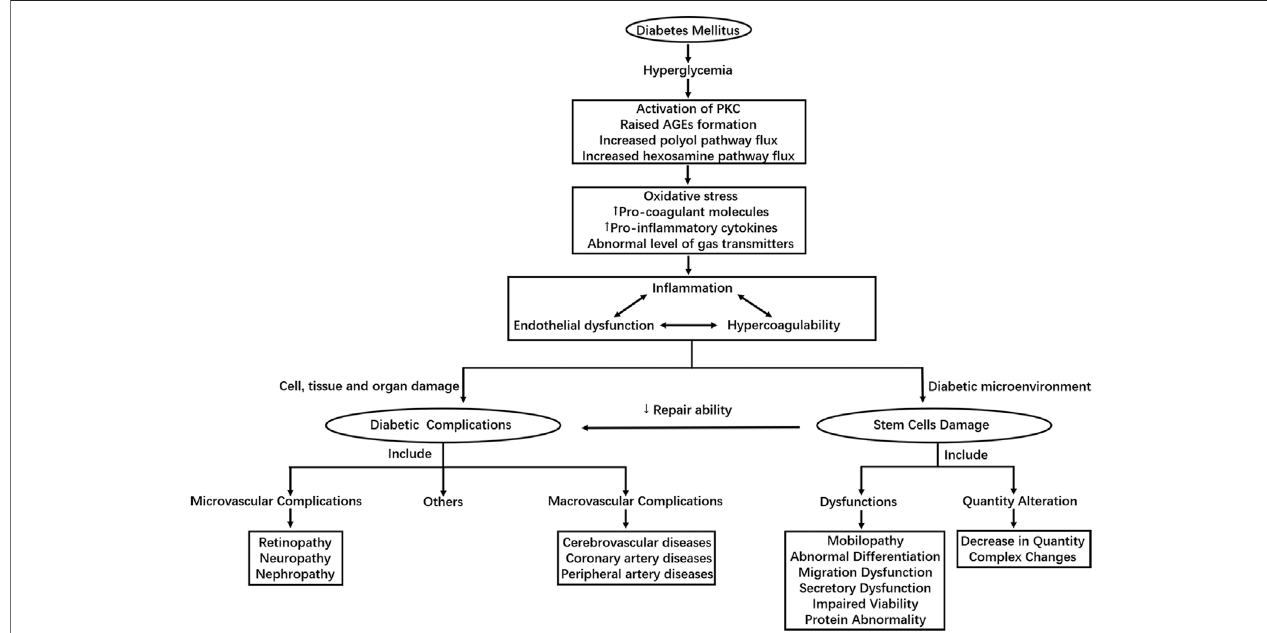
FIGURE 1 | Shows the main mechanism of diabetic complications and stem cell injuries caused by